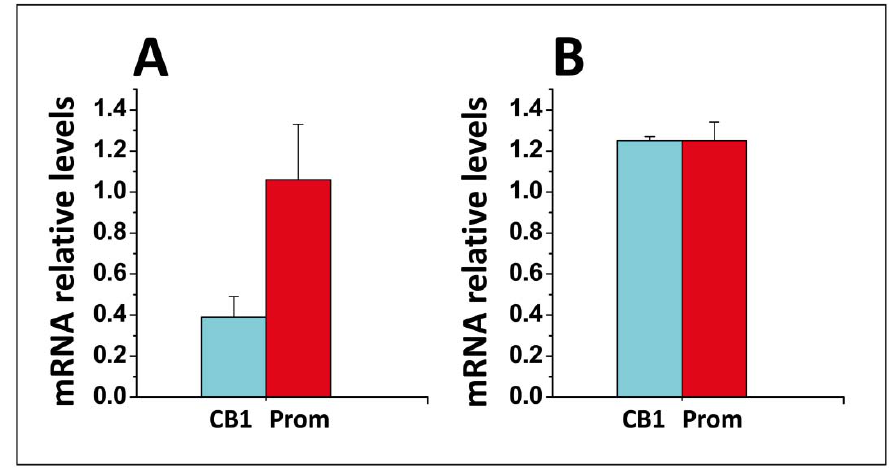
Figure 9. Real-time polymerase chain reaction (PCR) of CB1 messenger RNAs (mRNAs) in SH-SY5Y cells. A: Effect of a 24 h AEA treatment on the relative expression of CB1 and prominin (Prom) mRNAs. The results are expressed as the fold increase measured in anandamide-treated cells vs., control untreated cells (mean ± standard deviation (SD), n = 2). The data were presented as the fold change (2 − ∆∆ Ct ) in gene expression normalized to an endogenous reference gene (glyceraldehyde 3-phosphate dehydrogenase, GAPDH) and relative to a calibrator (non-treated cells). The quantification revealed that AEA induced a 2.5-fold decrease in CB1 gene expression whereas prominin gene expression was only slightly affected (1.06-fold increase). B: The data show the effect of anandamide on sphingomyelinase-treated cells. In this case, both CB1 and prominin gene expression were slightly higher (1.25-fold) by AEA [108].